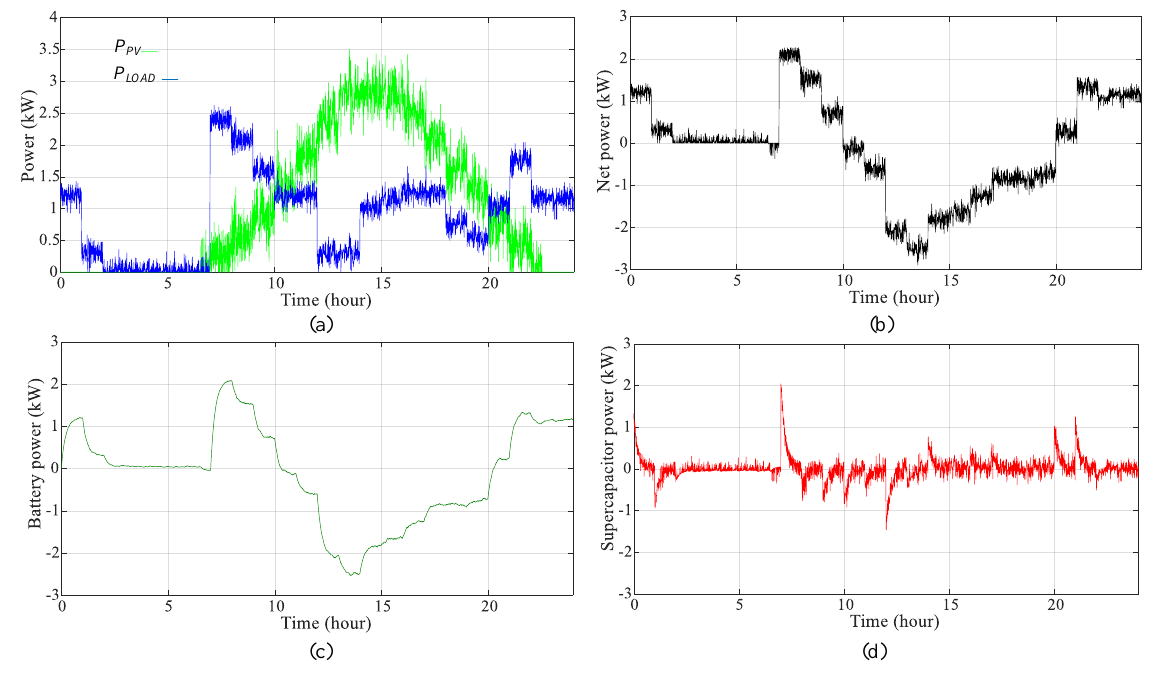
Figure 6. HESS power distribution. ( a ) P PV and P LOAD ; ( b ) P NET ; ( c ) P BAT and ( d ) P SC .